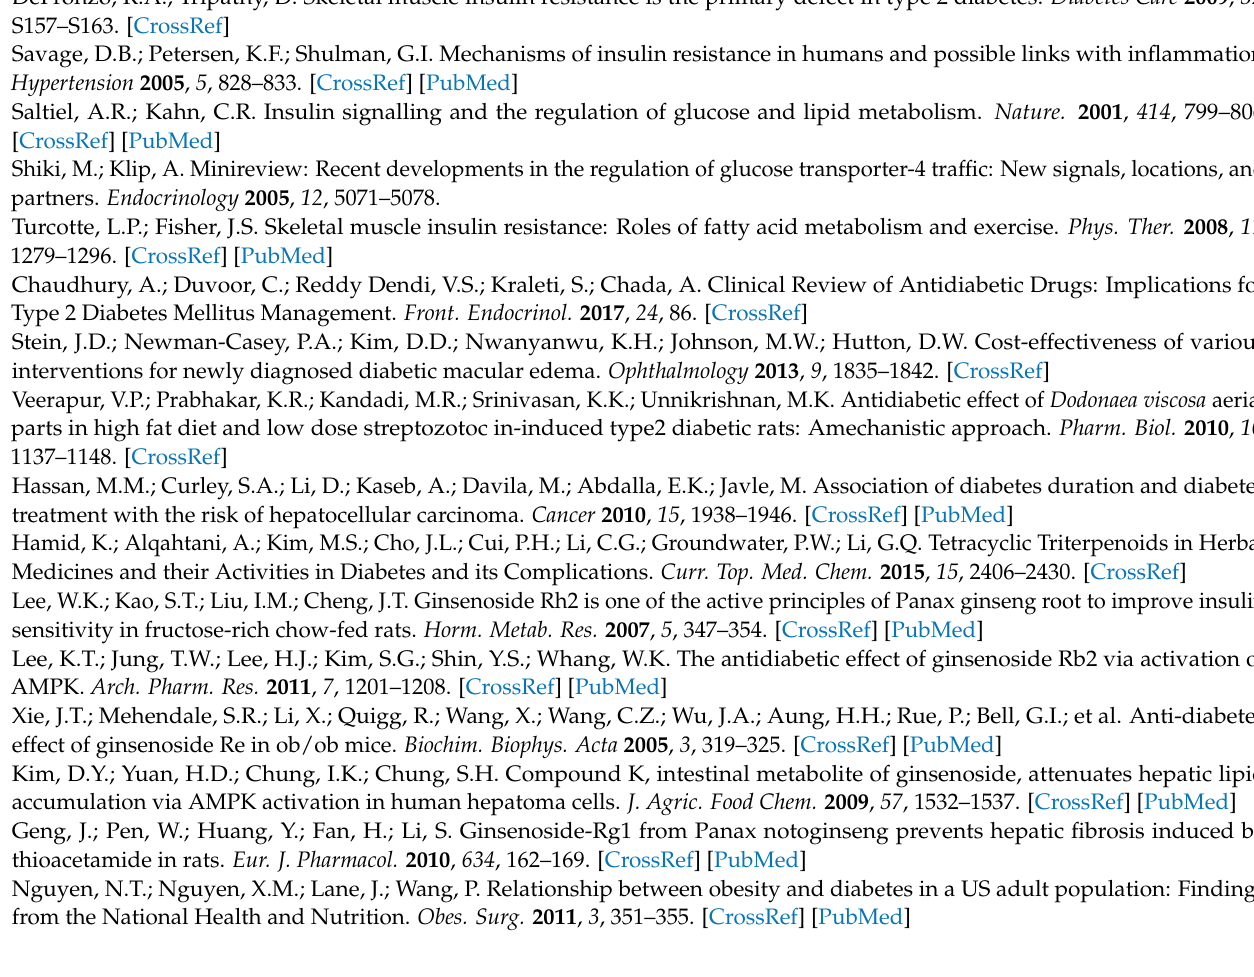
Supplementary Materials: Figure S1: Spectral analysis of novel compound 1 , Figure S2: Spectral analysis of novel compound 1 , Figure S3: Spectral analysis of novel compound 1 , (a) IR